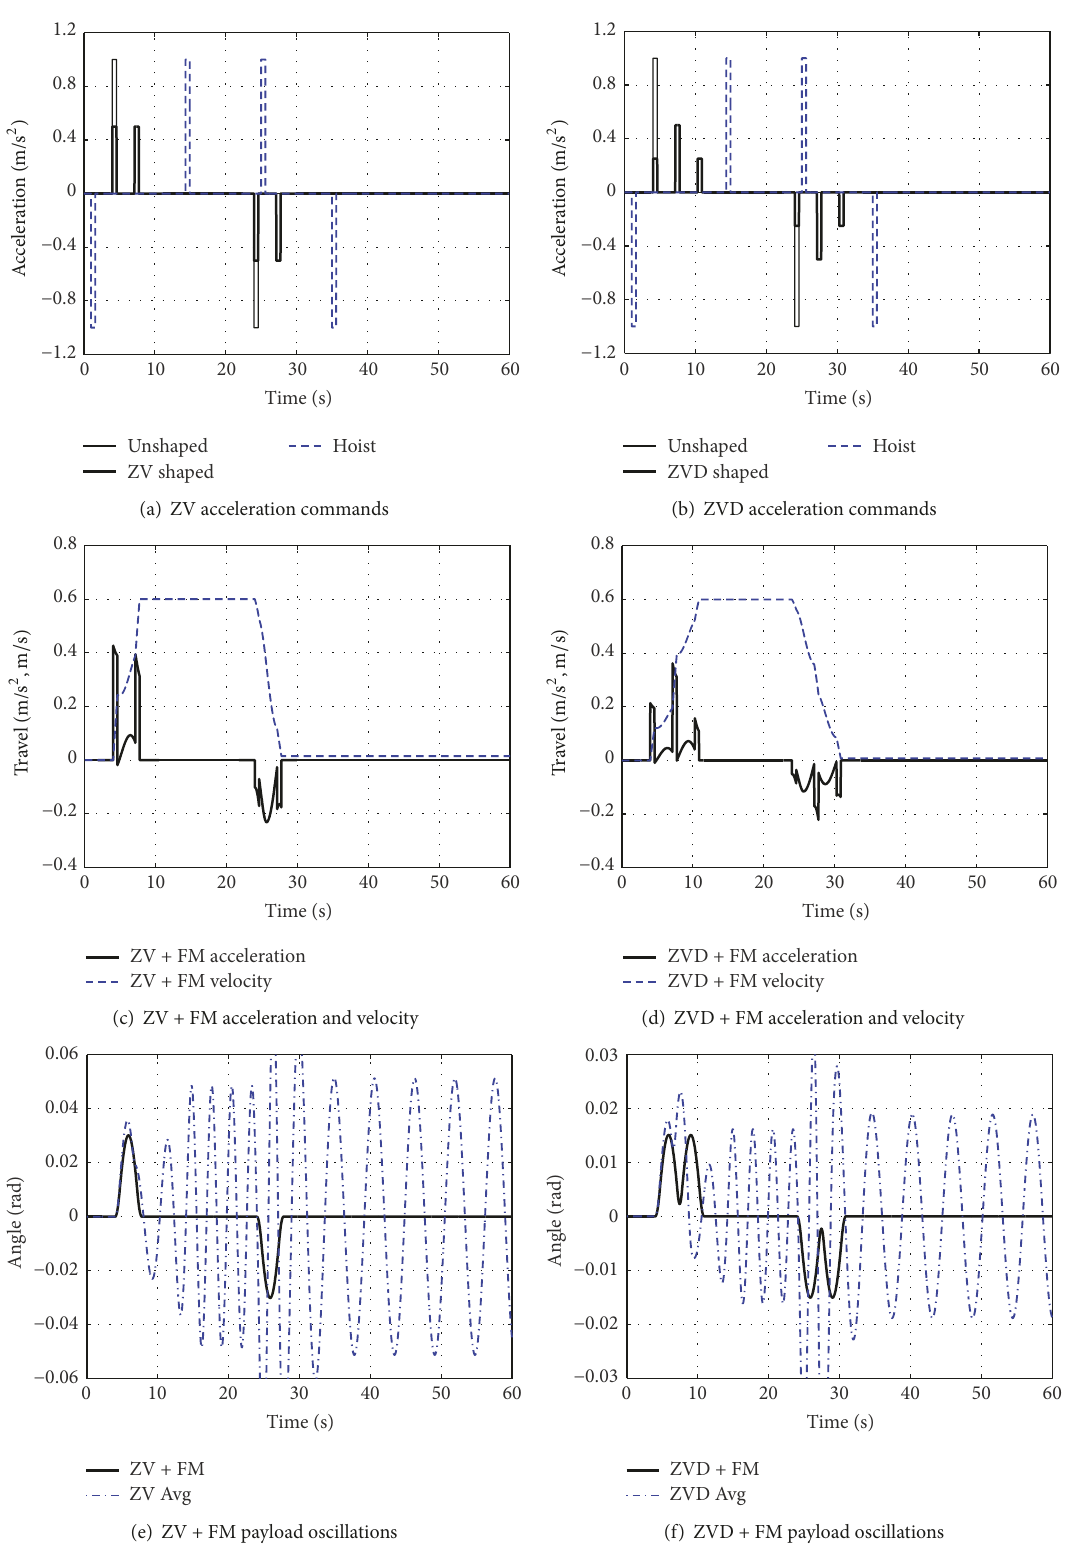
Figure 7: Simultaneous travel and hoisting maneuver using FM shaped